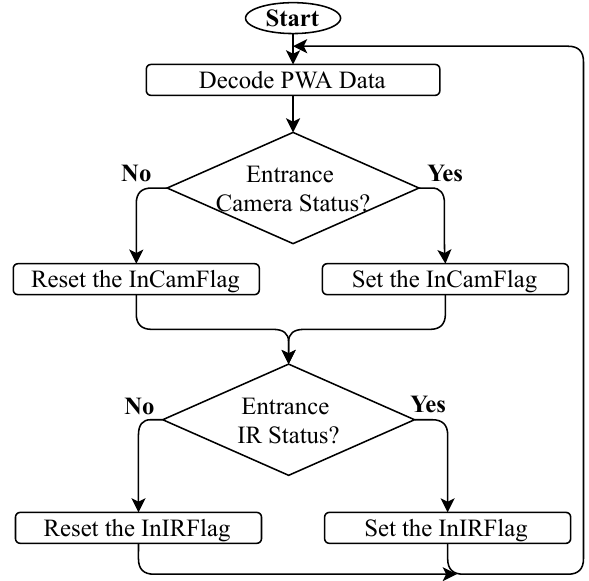
Figure 13. Flowchart of Entrance decoder PWA.